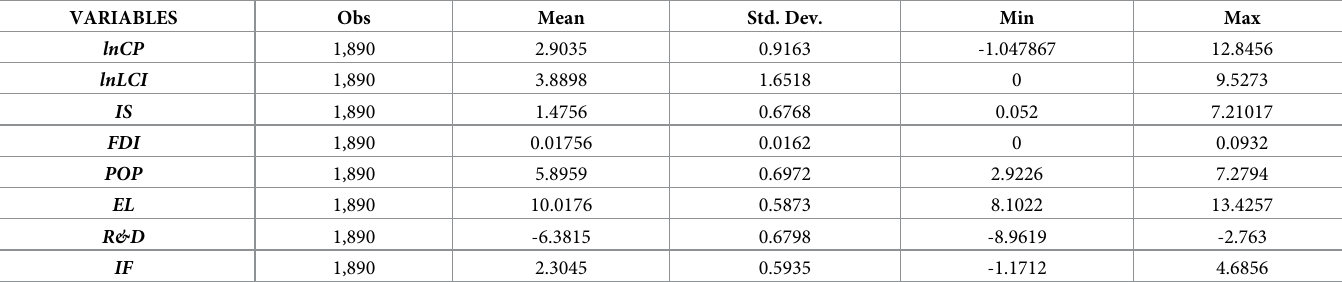
Table 1. Descriptive